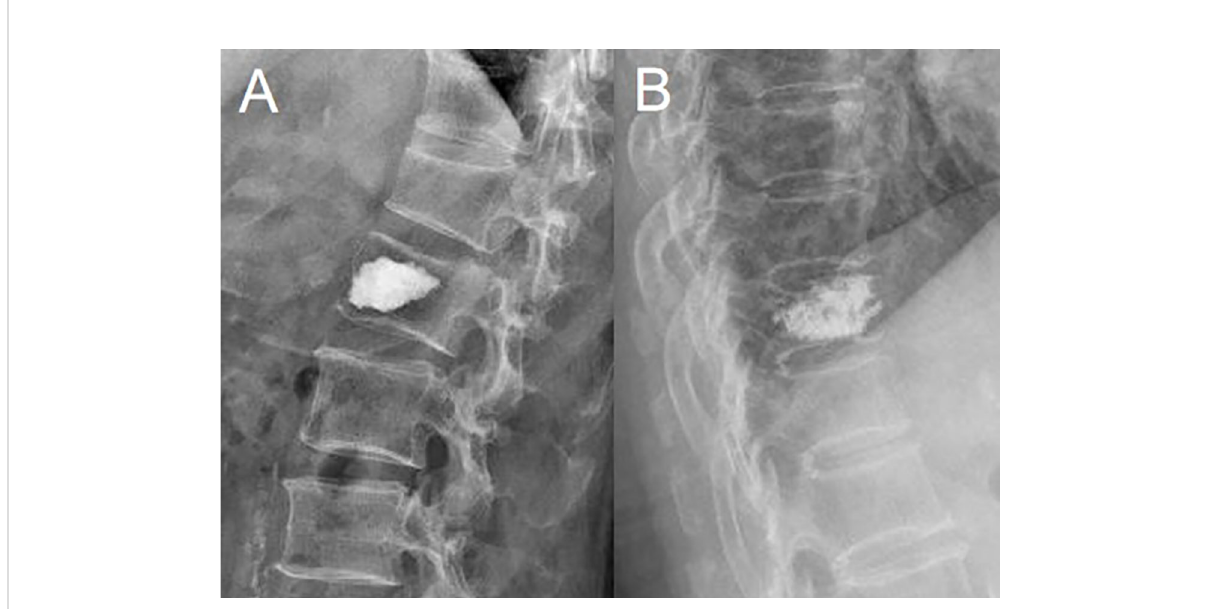
FIGURE 3 Cement distribution. (A) Compact type. (B) Trabecular type.